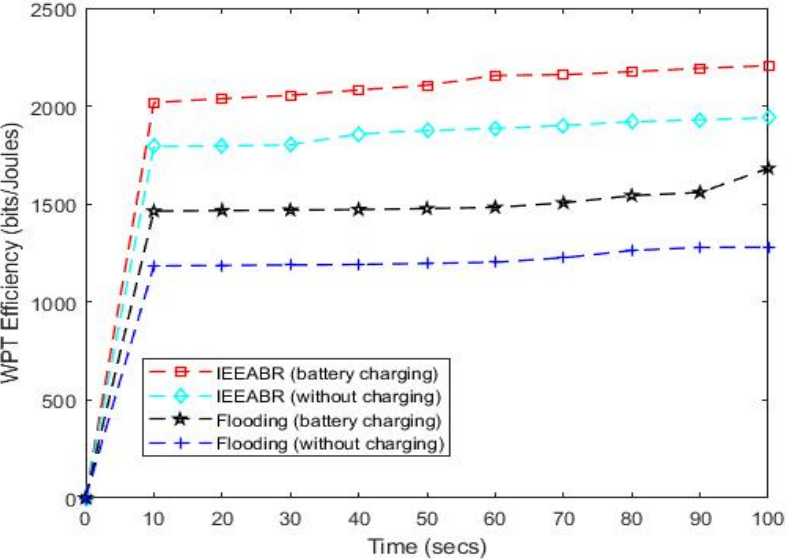
Figure 6. WPT efficiency at varying times of the wireless mobile battery charger (MBC) for MCBR-